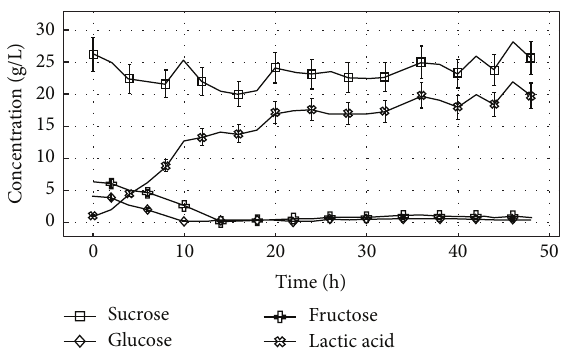
Figure 2: L. rhamnosus ATCC 10863 fermentation overview: sugars consumption and lactic acid production at fed batch fermentation